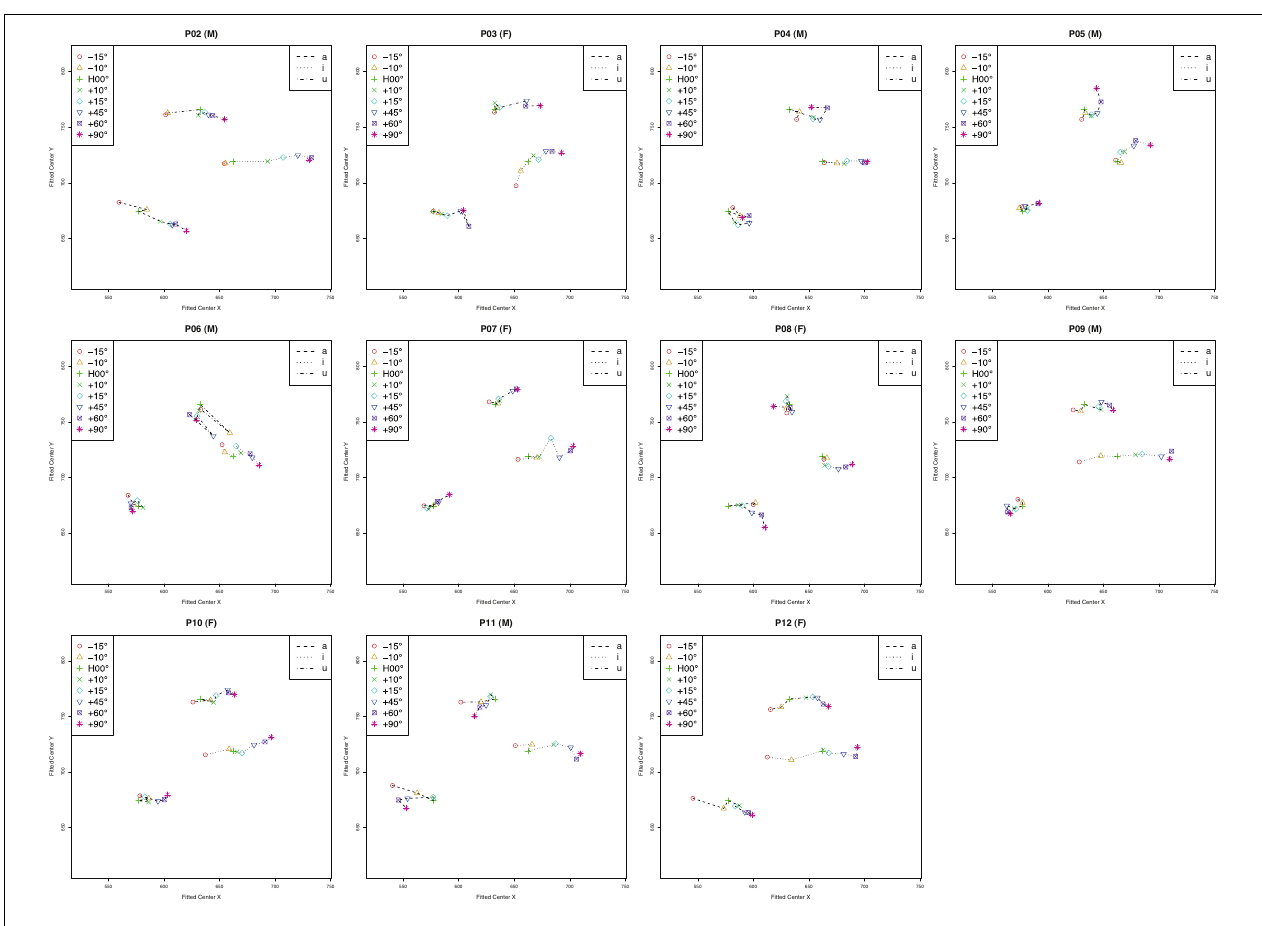
FIGURE A2 | Tongue center trajectories across different head angles arranged by participant. Trajectory patterns do not seem to differ systematically based on gender (male vs